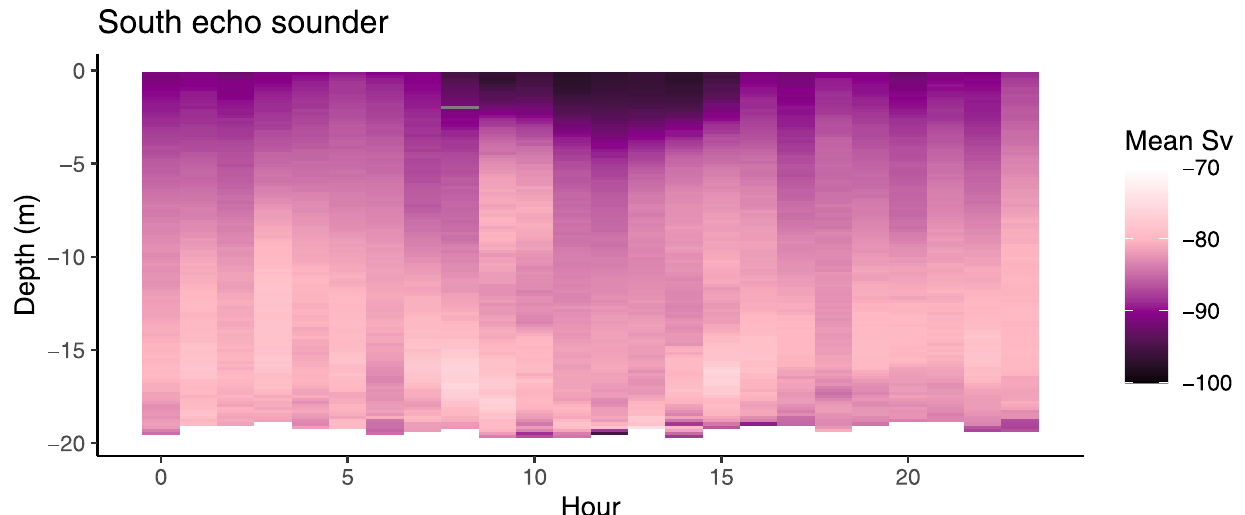
Fig 10. Depth and dispersal of fish seen in the south echo sounder over hour in the day when current is weak. Back scatter strength ( S density, with higher values (-70) indicating many fish and lower values (-100) indicating fewer fish. Data presenting current stronger than 0.11 m s -1 is not included for